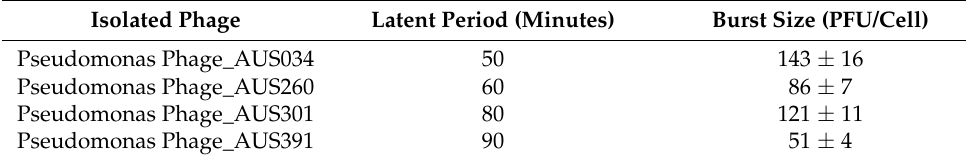
Figure 4. One-step growth curve of bacteriophages: (A) Pseudomonas Phage_AUS034, (B) Pseu- domonas Phage_AUS260, (C) Pseudomonas Phage_AUS301 and (D) Pseudomonas Phage_AUS391. Table 5. The latent period and burst size of the isolated phages.